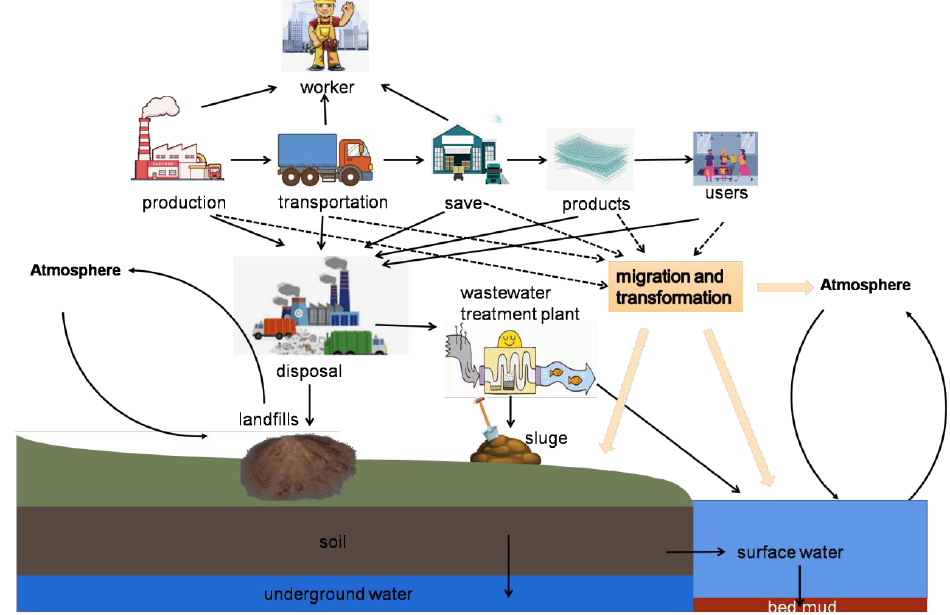
Figure 1. Routes of migration and transformation of NPs in the environment. Among these subjects, microorganisms, as one of the most biodiverse species on earth, are the basis of the entire food chain and play a leading role in the earth ’ s material and energy cycles. Because microbial communities have these important ecological func- tions and their ubiquitous distribution characteristics in environmental media, it is partic- ularly important to study the eco-toxicity of NPs to microbial communities. Studies have shown that NPs in soil, water and atmosphere can affect the growth and physiological activity of microorganisms by coexisting with microorganisms, adsorbing on the surface of microorganisms and even entering the organism. However, the impact of NPs on the structure and diversity of microbial communities is much more complicated. The type, exposure time and concentration of NPs will have different effects on the structure and diversity of microbial communities [30,31]. Similarly, the heterogeneity of different envi- ronments brings about different environmental changes to NPs, leading to different ef- fects of the same type of NPs on the diversity of microbial communities [32]. In addition, some NPs have been found to have certain effects on specific bacterial groups. Therefore,